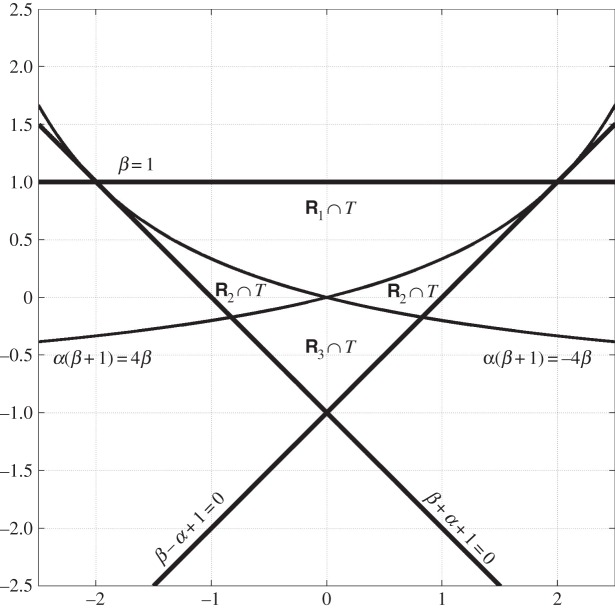
Optimal region of invertibility in lemma 4.1. The horizontal axis is α and the vertical axis is β.